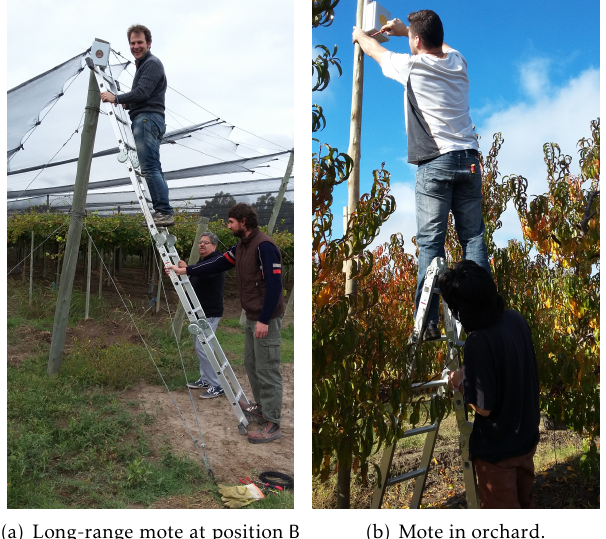
Figure 11. The SOL back-end